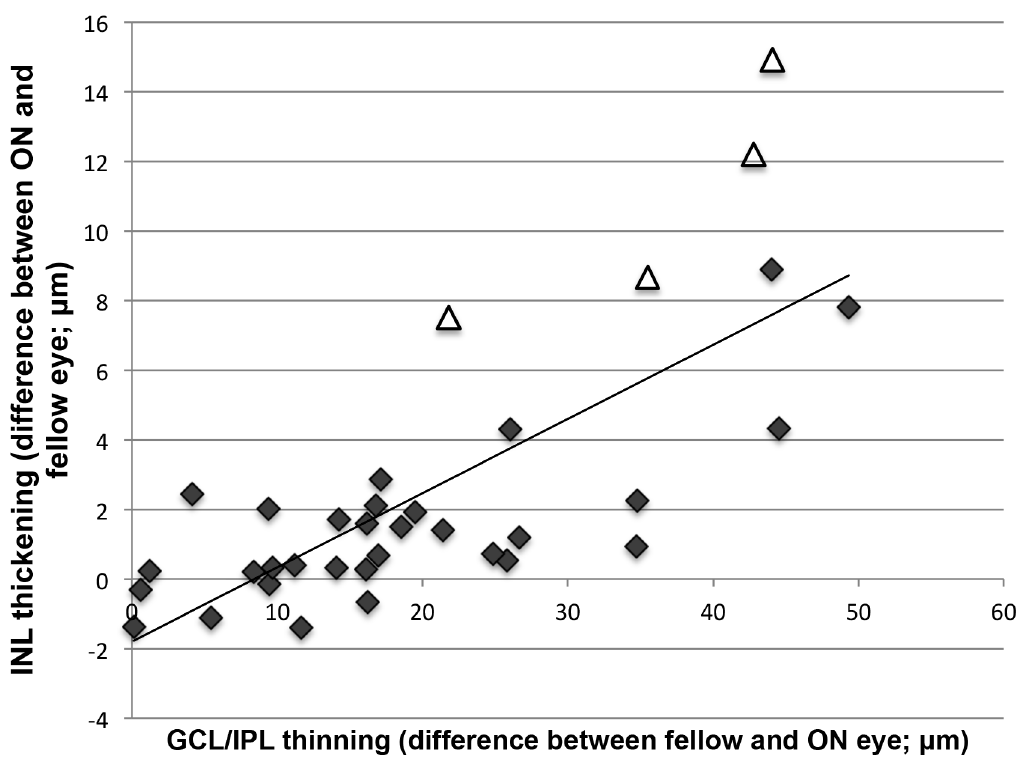
Figure 2. Correlation between GCL/IPL and INL in the ON group after removing inter-subject variability. The four triangles represent the ON patients with INL microcysts. The diamonds represent the ON patients without microcysts.